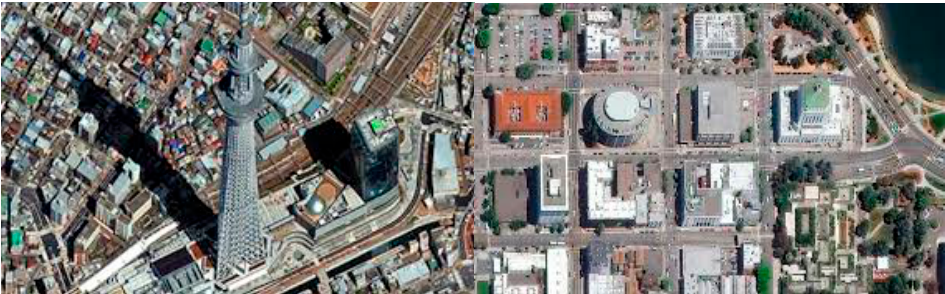
Figure 9. Exemplar off-nadir high resolution images from WV-2.